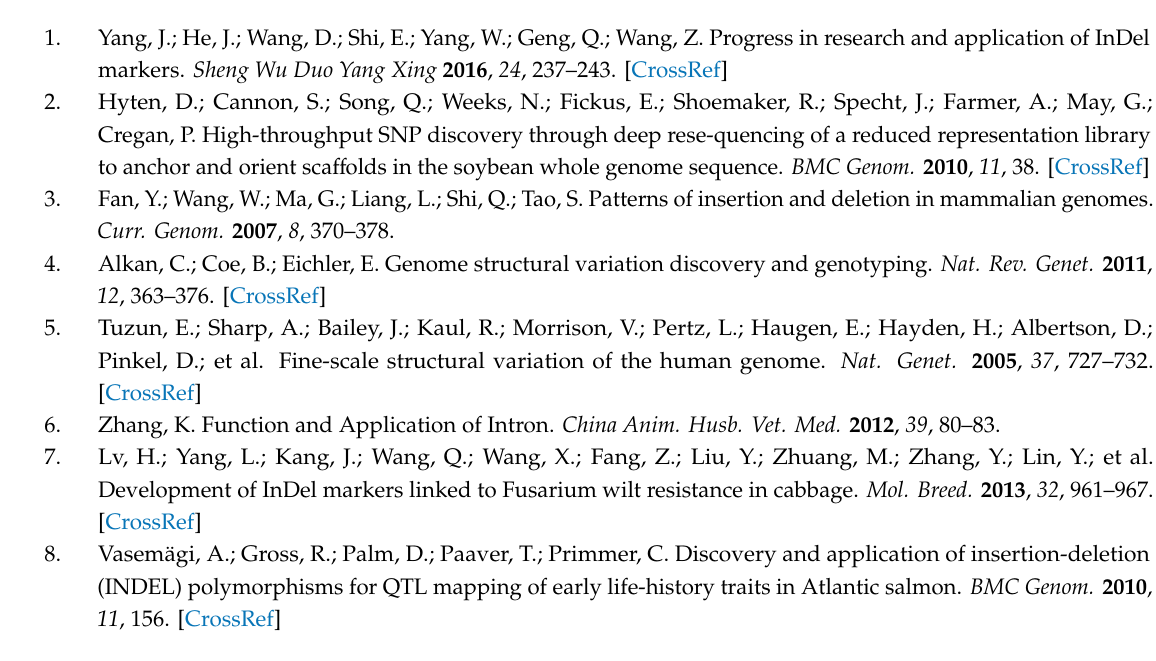
Table S1: PCR primer sequences of InDels in sheep GH , GHR , GHRH, and GHRHR genes, Table S2: Hardy–Weinberg equilibrium test for gene frequency and genotype frequency of six mutant sites in seven populations, Table S3: Relationship between variations of GHR , GHRH, and GHRHR and their growth traits ( p < 0.1). Author Contributions: Data analysis, H.Z. and Q.L.; Manuscript writing, M.W. and X.T.; experimental